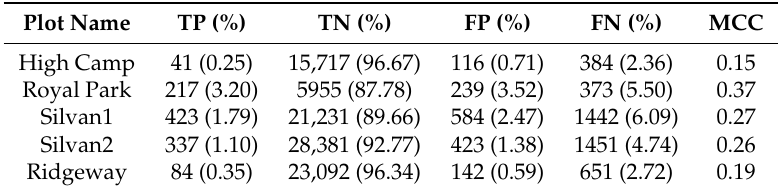
Table 4. Summary of confusion matrix results between SfM normalised point cloud and validation frame data. For each plot, True Positives (TP), True Negatives (TN), False Positives (FP), False Negatives (FN) and Matthews Correlation Coefficient (MCC) are